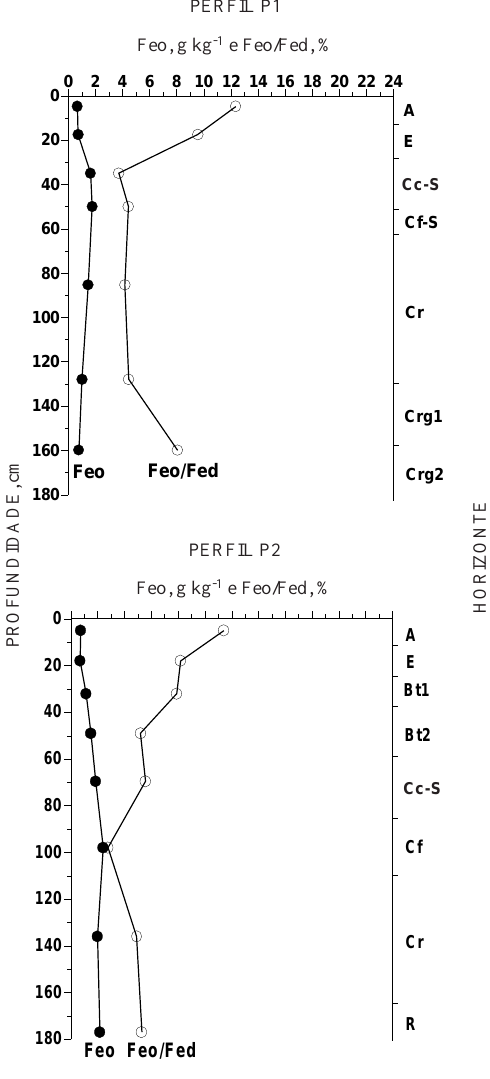
Figura 4. Distribuição, em profundidade, do ferro extraído com oxalato-oxálico (Fe Feo/Fed para os perfis estudados (nos horizontes nodulares considerou-se apenas sua matriz